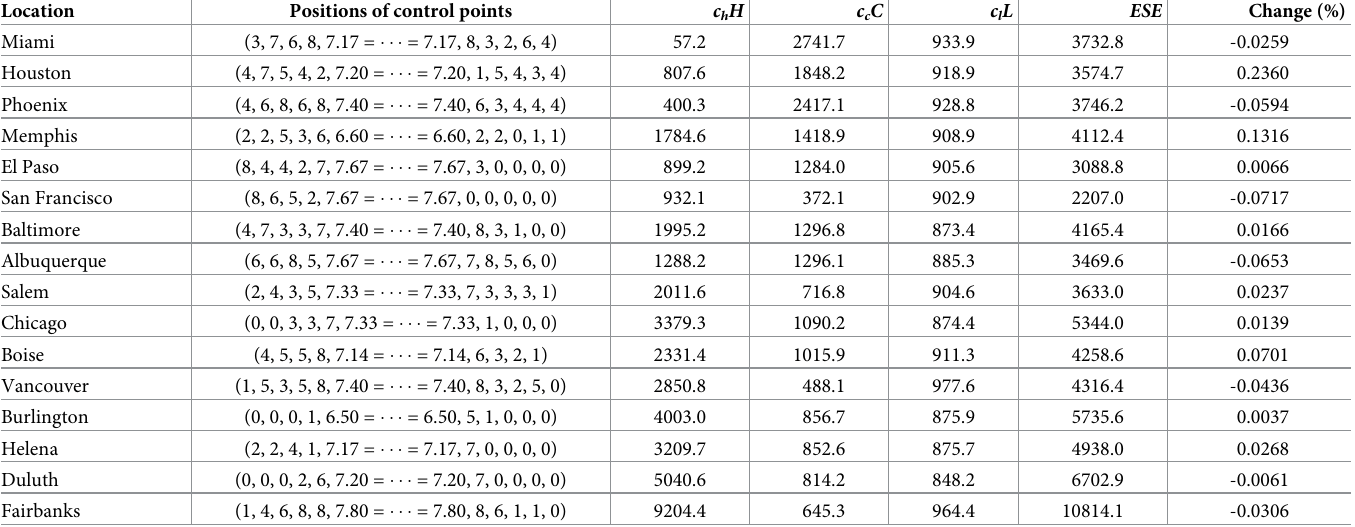
Table 8. Overhang rectification in optimal shadings.